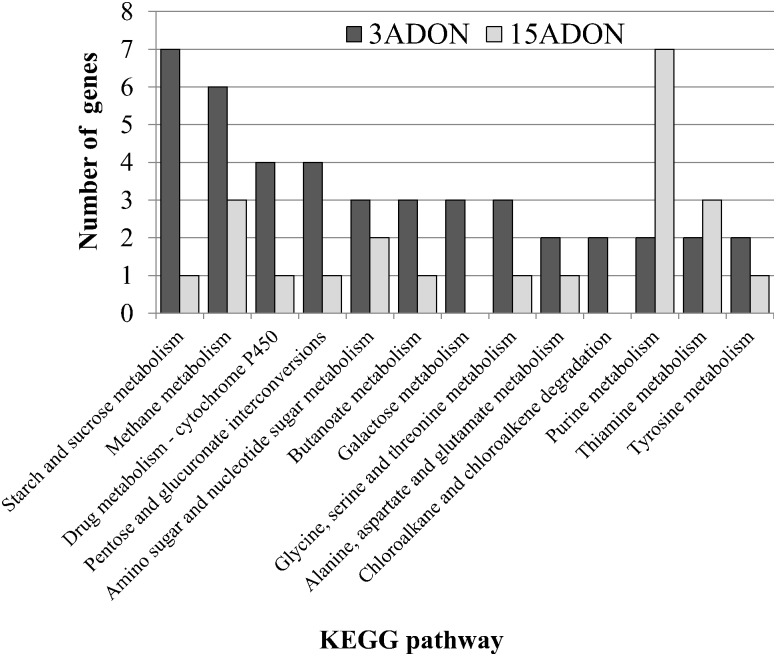
Kyoto Encyclopedia of Genes and Genomes (KEGG) pathway analyses of in vitro up-regulated genes.Values with log2 fold change >1 and false discovery rate (<0.01) were considered as differentially expressed. Only pathways having at least two genes up-regulated on either of the population are shown. Detailed information on KEGG pathway analysis is given in S1 Table.